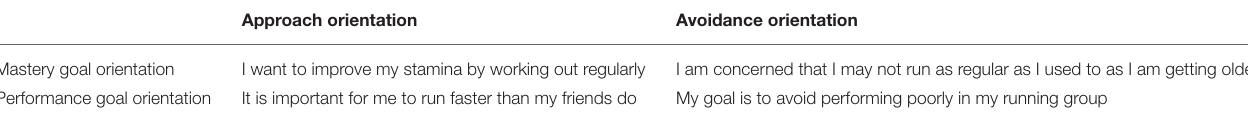
TABLE 1 | A 2 is × 2 achievement goal framework. Approach orientation Avoidance